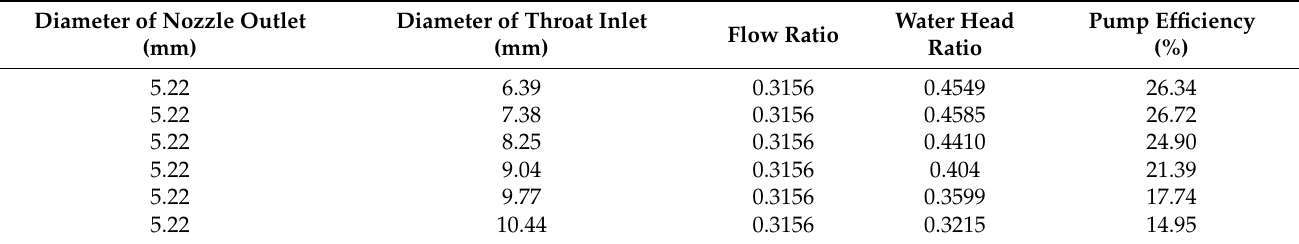
Figure 6. Velocity cloud diagrams from the nozzle outlet to the throat inlet with different throat – nozzle distances. nozzle distances. Table 5. Effect of different area ratios on pump